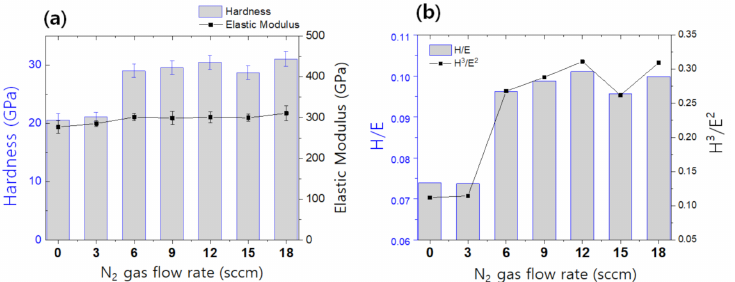
Figure 4. ( a ) Hardness and elastic modulus of Mo–Cu–Cr–N coatings prepared with various N 2 gas flow rates and ( b ) HIT/EIT and HIT 3 /EIT 2 of the Mo–Cu–Cr–N